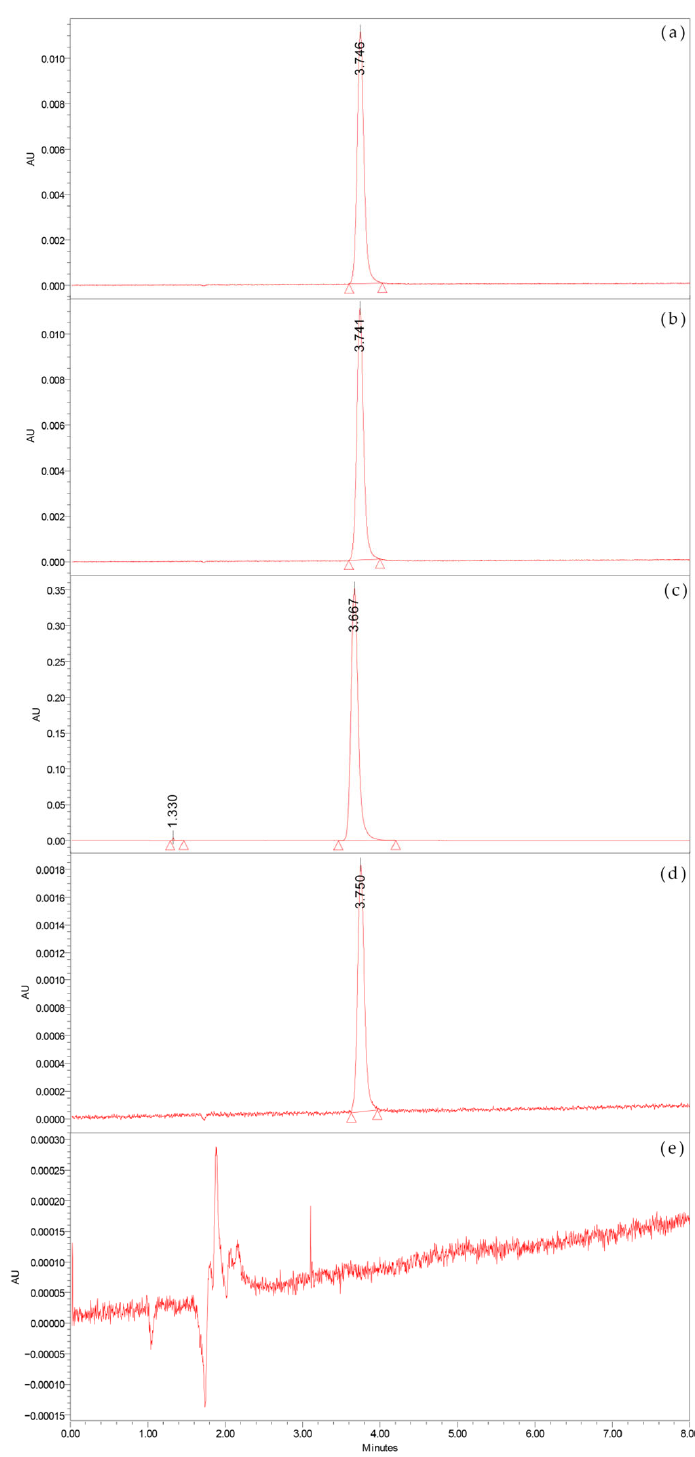
Figure 1. UPLC chromatograms (368 nm) of AA-API ( a ), a photolysis sample ( b ), visible foreign solids ( c ), intermediate polymer, ( d ) and blank excipient ( e ). For both AA ‐ API and the visible foreign solids, secondary scans of the quasi ‐ molec ‐ ular ion [M ‐ H] ‐ at m/z 233 were further performed, and the ESI ‐ MS 2 scan mass spectra (Figure 2) revealed that the [M ‐ H] ‐ parent ion mainly yielded 10 fragment ions with rela ‐ tively large abundances, including ions with m/z of 214.99, 203.06, 191.02, 189.02, 171.02, 162.99, 161.01, 158.95, 147.01, and 135.01.